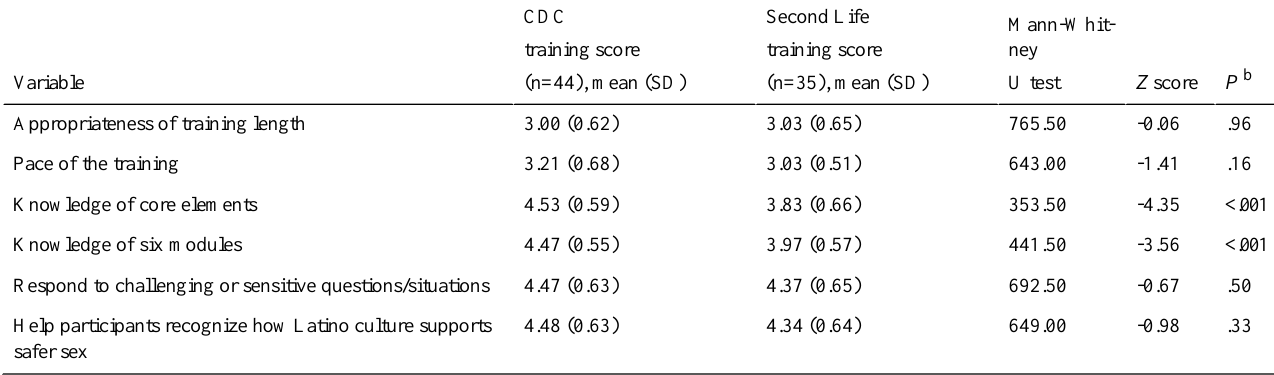
Table 3. Nonparametric comparisons of participant ratings between CDC a face-to-face training and Second Life